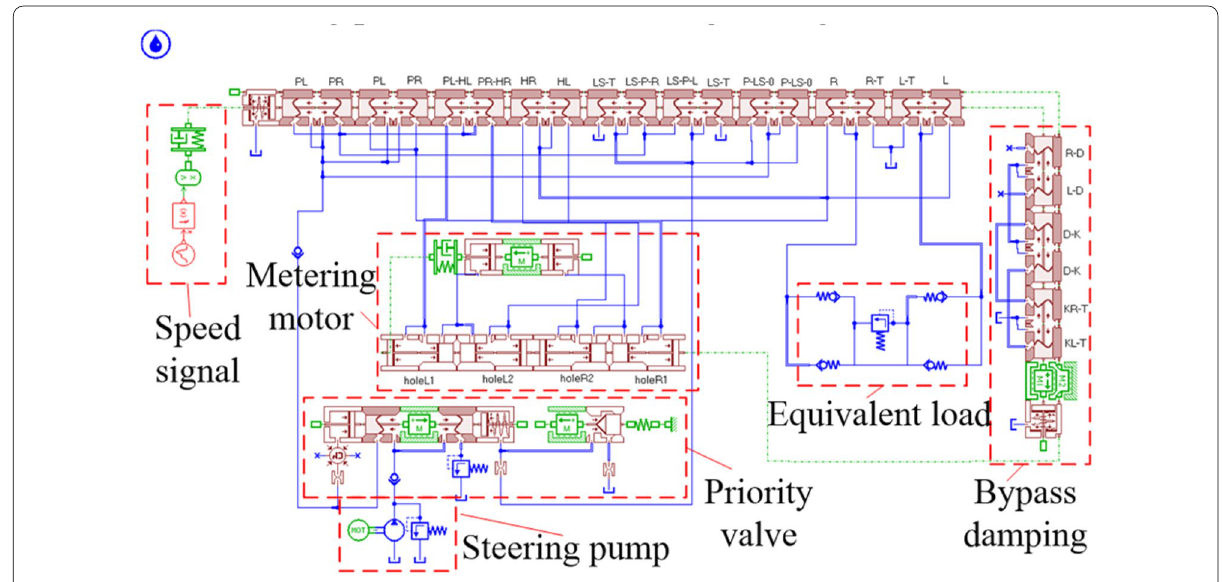
Figure 5 Simulation model of the novel redirector